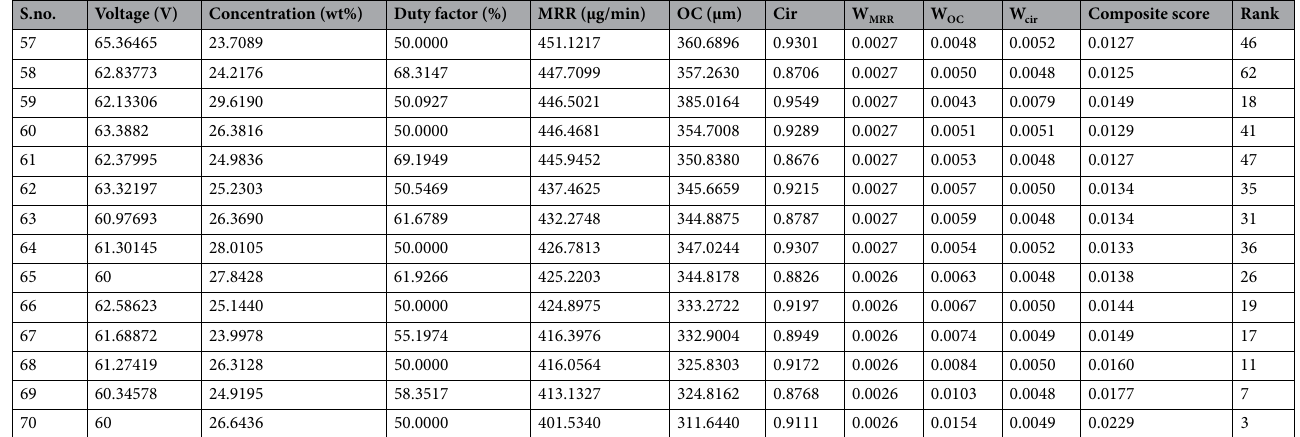
Table 4. Ranking of Pareto optimal solutions using R-method. Significant values are in bold.